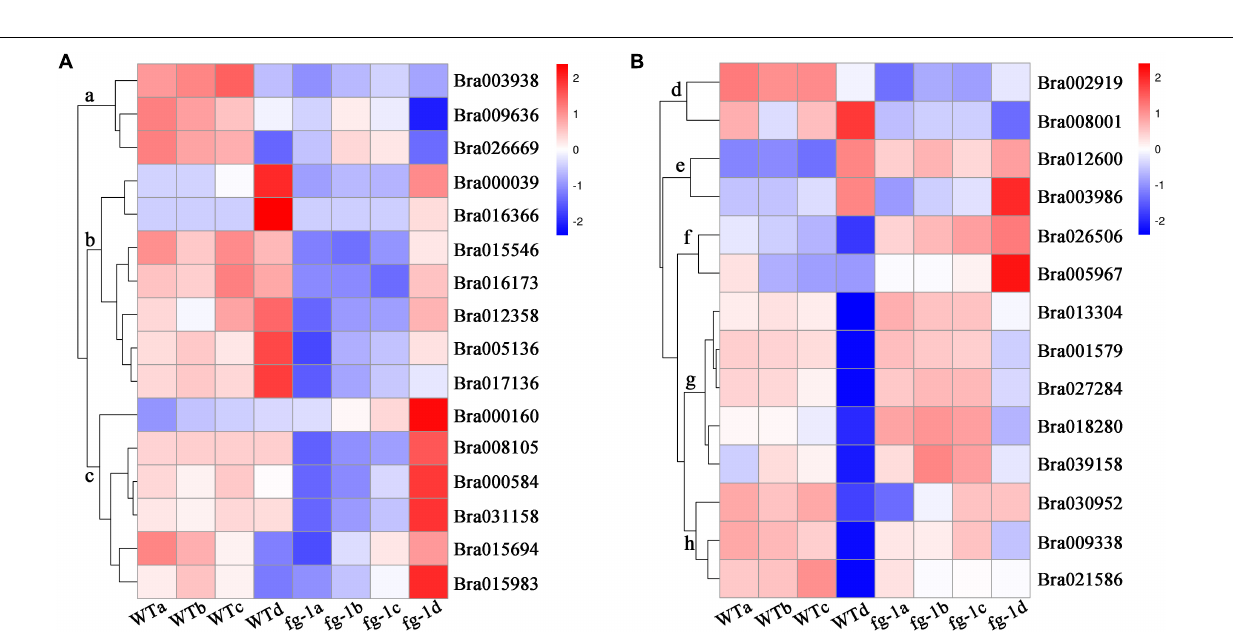
Frontiers in Plant Science |